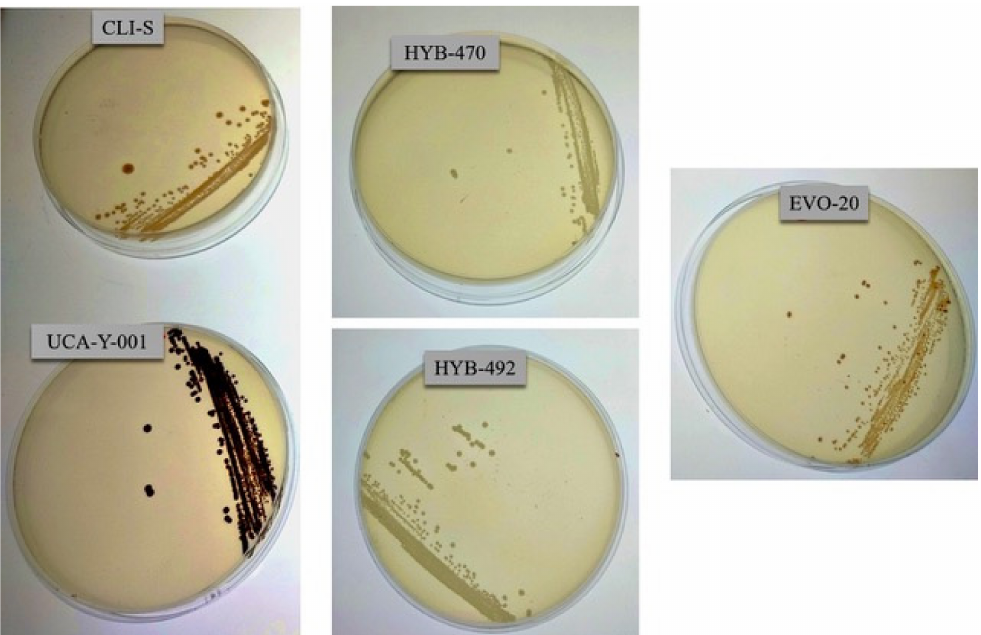
Figure 2. Qualitative evaluation of hydrogen sulfide on BiGGY agar plates of parental (UCA-Y-001, CLI-S) and the three evolved variant strains selected (HYB-470, HYB-492, EVO-20) to carry out fermentation at an industrial scale. The darker the colony, the more H 2 S is being produced.